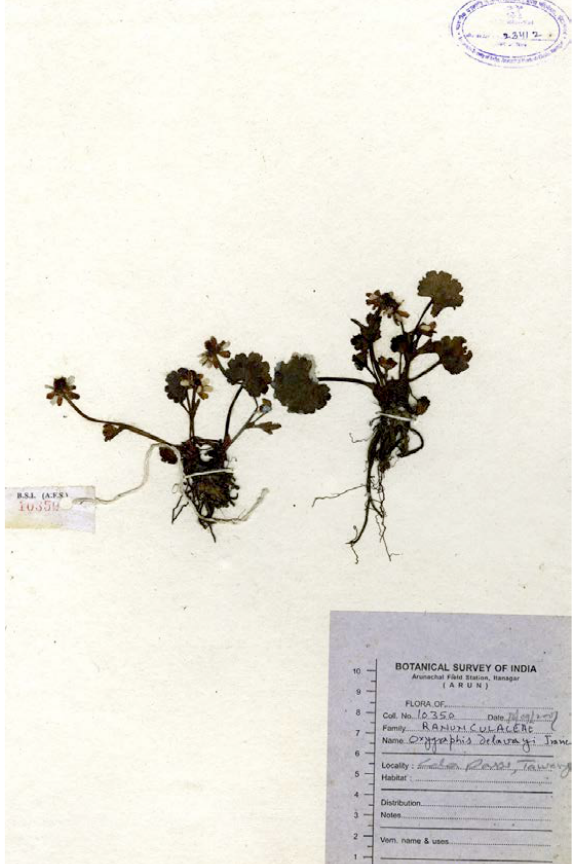
Figure 1. Oxygraphis delavayi a - plant habit; b - flower; c - Sepal; d - Petal; e - Stamen. A -­‐ Illustration of plant habit; B -­‐ Illustration of Flower; C -­‐ Sepal; D -­‐ Petal; E -­‐ Stamen.